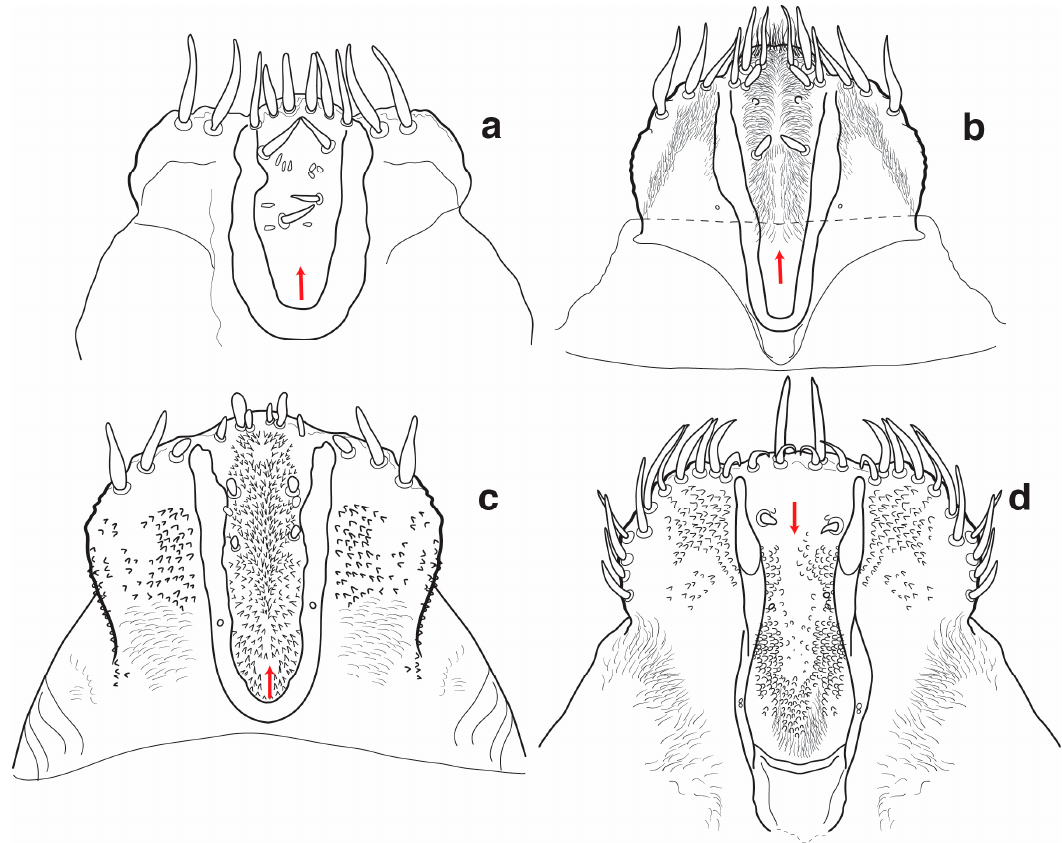
Figure 23. Epipharynx, larva: ( a ) Tryphetus ; ( b ) Sphenophorus ; ( c ) Phacecorynes ; and ( d ) Rhynchophorus . 10. Orientation/placement of mesal asperites of epipharynx (Figure 24) a. Asperites absent or on labral rods